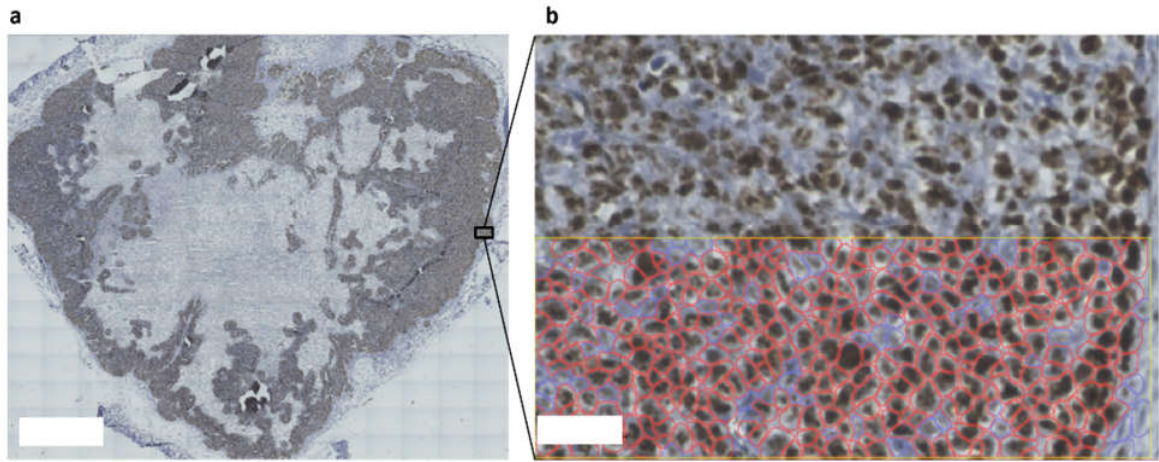
Figure 3. An HCT116 xenograft with a proliferating shell and a nonproliferating core. ( a ) HCT116 xenografts stained for proliferation marker Ki67 (brown) contained peripheral regions with high proliferation and large areas of nonproliferating tissue toward the core. Scale bar = 2 mm. ( b ) Proliferating areas were ~80% Ki67-positive. Ki67 quantification was performed by Qupath software; positive cells are shown in red [27]. Scale bar = 50 µm.